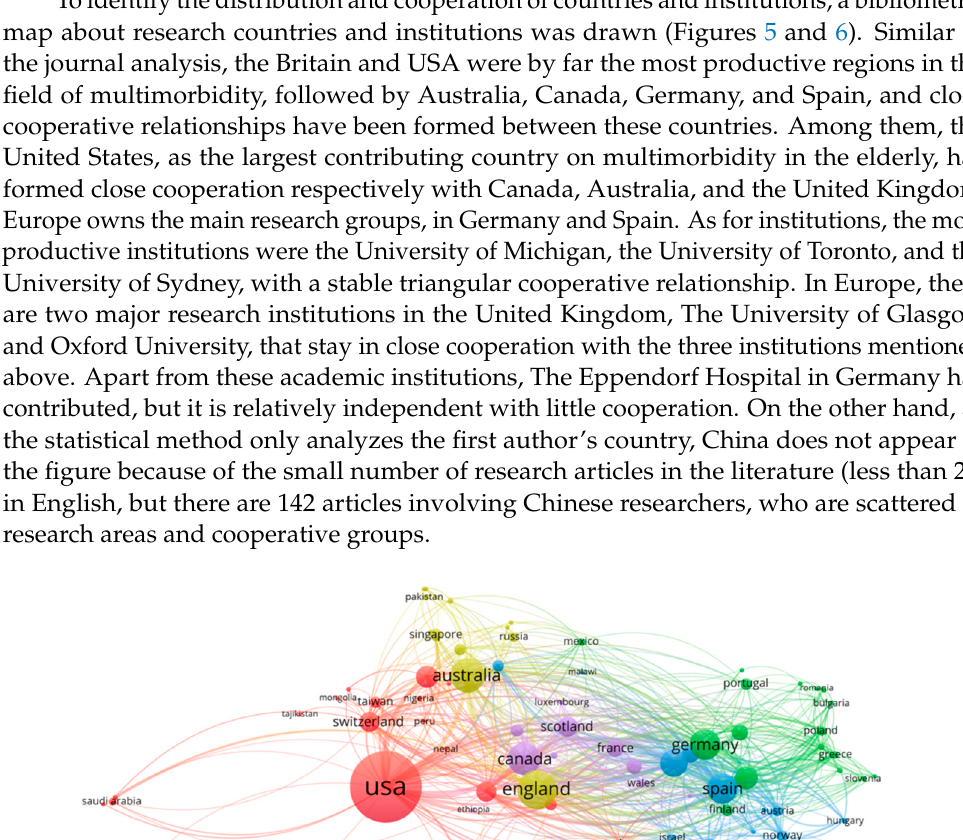
Figure 6. Co-institution analysis of global research. 4.4. Core Keyword Co-Occurrence Analysis Over time, a knowledge map of keyword co-occurrence can reflect hot topics, and burst keywords (keywords that are cited frequently over a period of time) may indicate frontier topics [36]. VOSviewer was utilized to construct a knowledge map of co-occurring keywords. In the 3857 foreign articles in English (Figure 7, Table 3). Among them, “Mul- timorbidity” (748 times), and “Chronic disease” (418 times) were the most frequent words which are reasonable because they are the search terms. Except for them, other keywords actually reflect hotspots and topics that researchers are focusing on. “Prevalence” (591